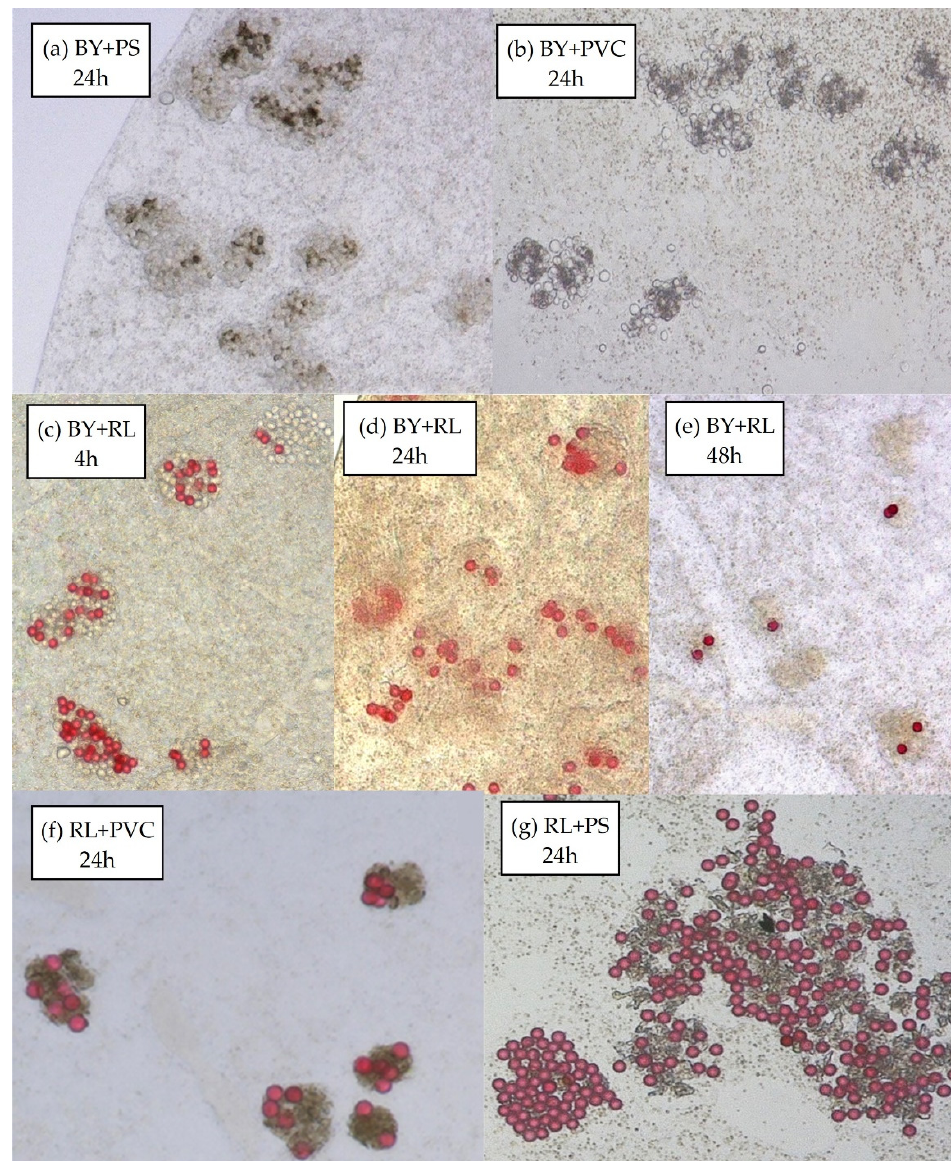
Figure 5. Food vacuoles with the mixture of particles: ( a ) BY + PS after 24 h; ( b ) BY + PVC after 24 h; ( c ) BY + RL after 4 h; ( d ) BY + RL after 24 h; ( e ) BY + RL after 48 h; ( f ) RL + PS after 24 h; ( g ) RL + PVC after 24 h.